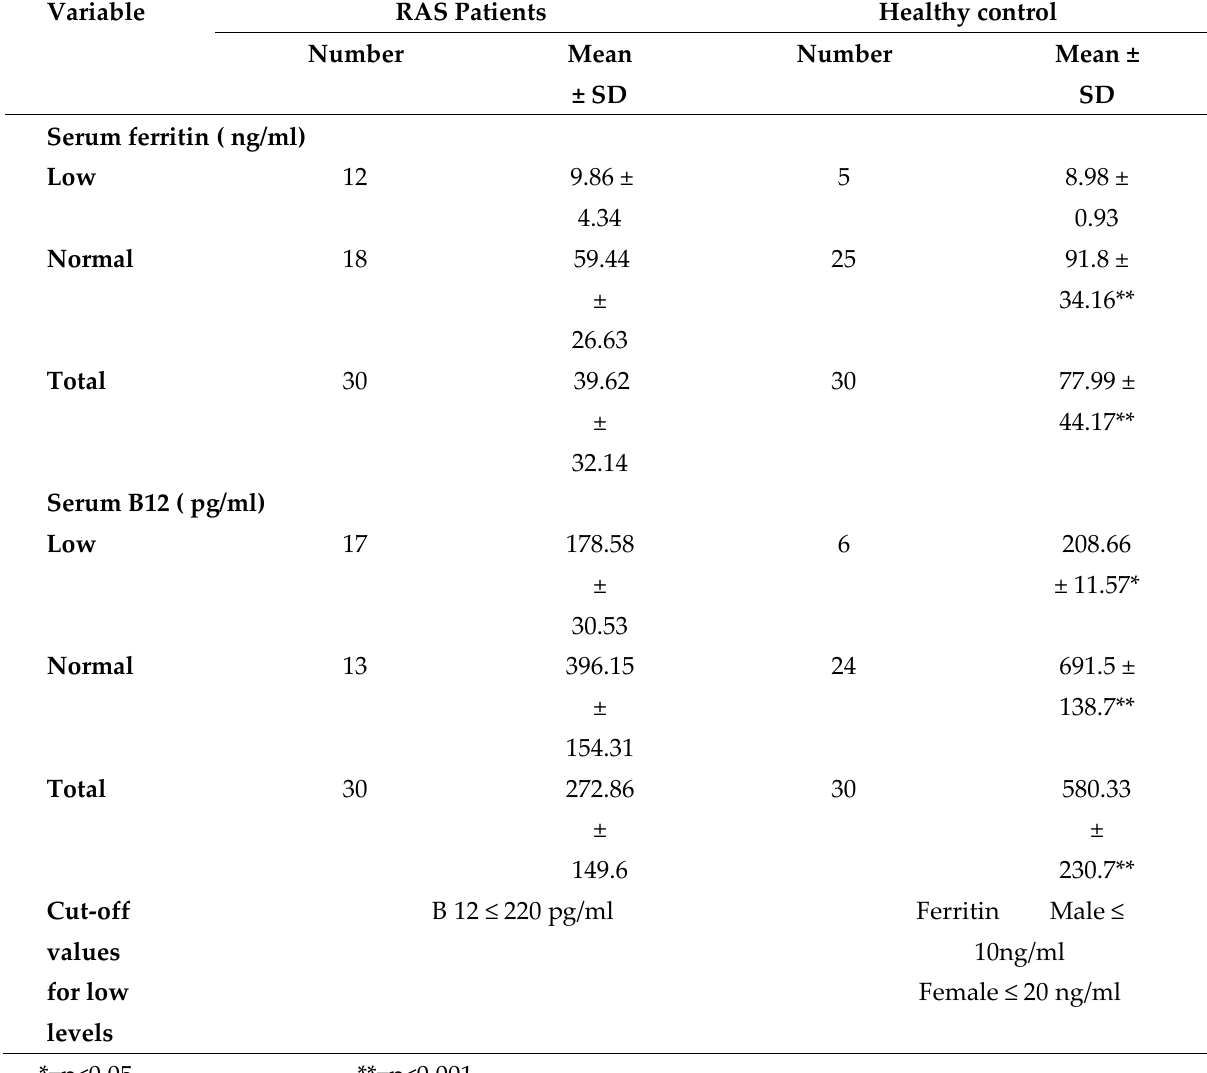
Table2: A comparison of serum ferritin levels and vitamin B12 levels in RAS patients and controls. Variable RAS Patients Healthy